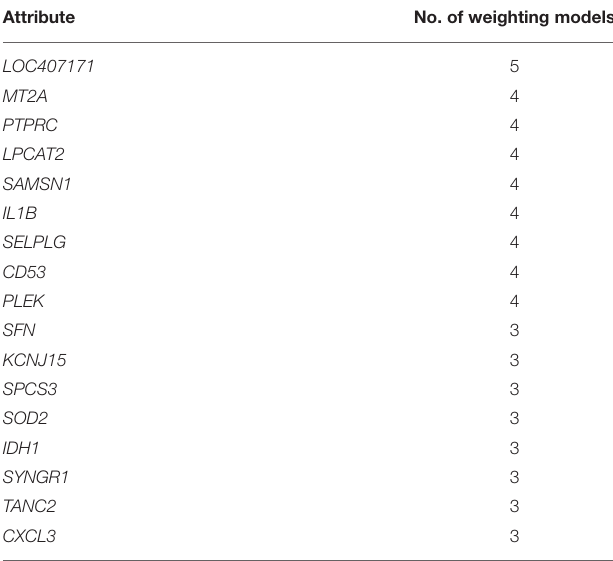
TABLE 6 | Results of different attribute weighting algorithms confirmed the most important genes.